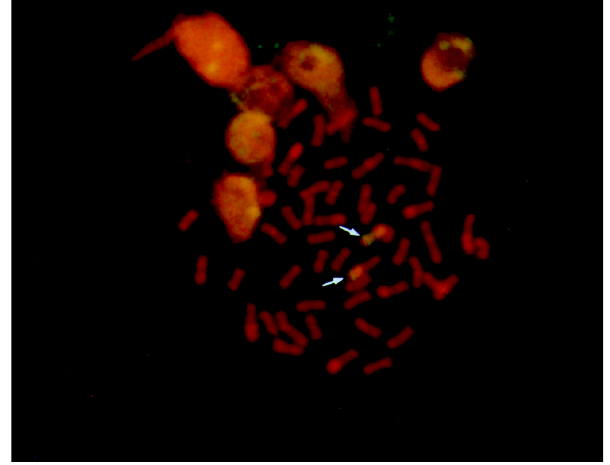
Figure 3 - Metaphase of Leporinus desmotes female observed after rDNA/ FISH. The NOR-bearing chromosomes (9th pair) are indicated by